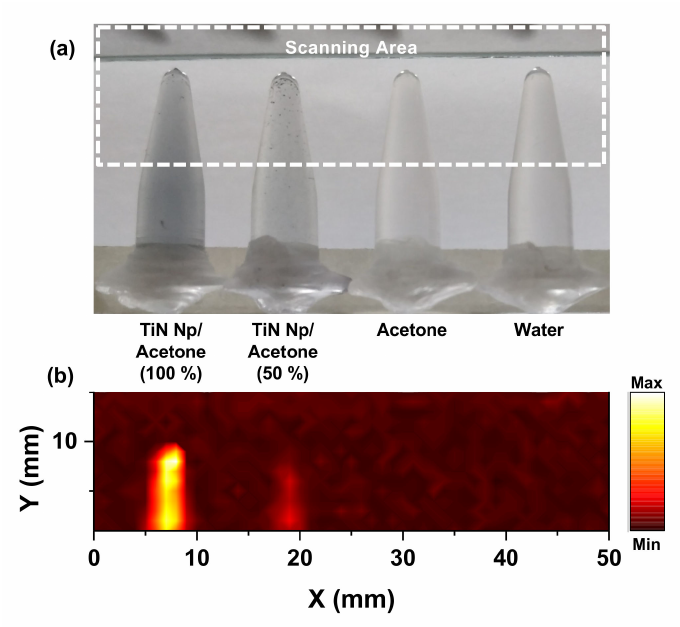
Figure 13. ( a ) Image of TiN NP/ acetone samples with 100% and 50% concentration, acetone and D.I. water, ( b ) PAI of the samples excited with 6 mJ/cm 2 , 532 nm, 10 Hz, ~5 ns pulsed laser source. The PAI is obtained with a single element 5 MHz ultrasonic transducer, (V310-N-SU (Olympus, Waltham, MA,